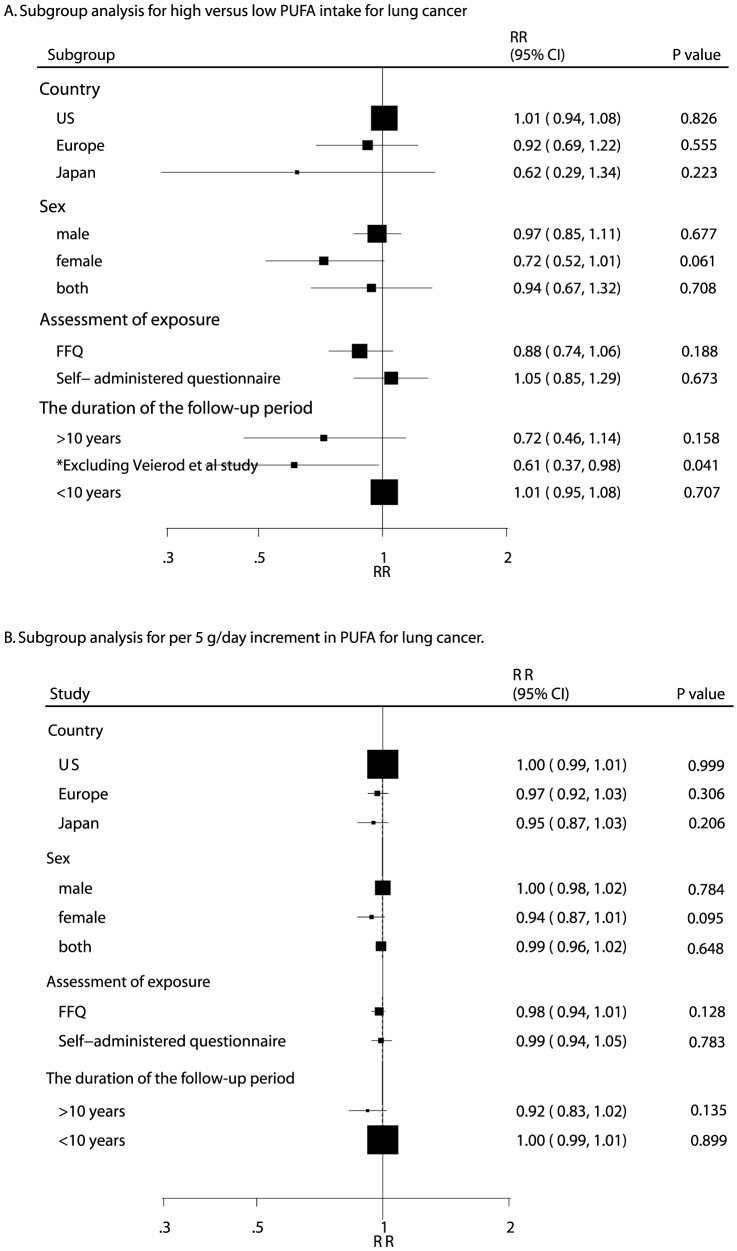
Subgroup analysis for high versus low PUFA intake for lung cancer (A); Subgroup analysis for per 5 g/day increment in PUFA intake for lung cancer (B).